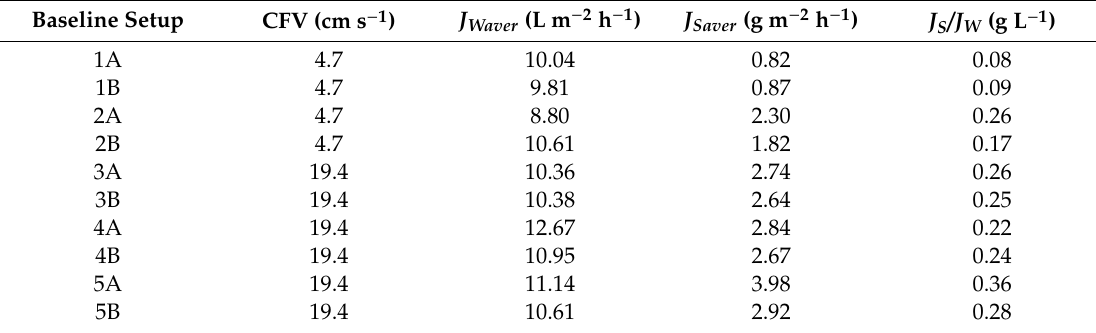
Table 1. Baseline experiments and membrane performance. The number in the “baseline set-up” column corresponds to the membrane coupon that subsequently used for the experimental setup with the conditions described in Figure 2 and the letter (A or B) the repetition of the